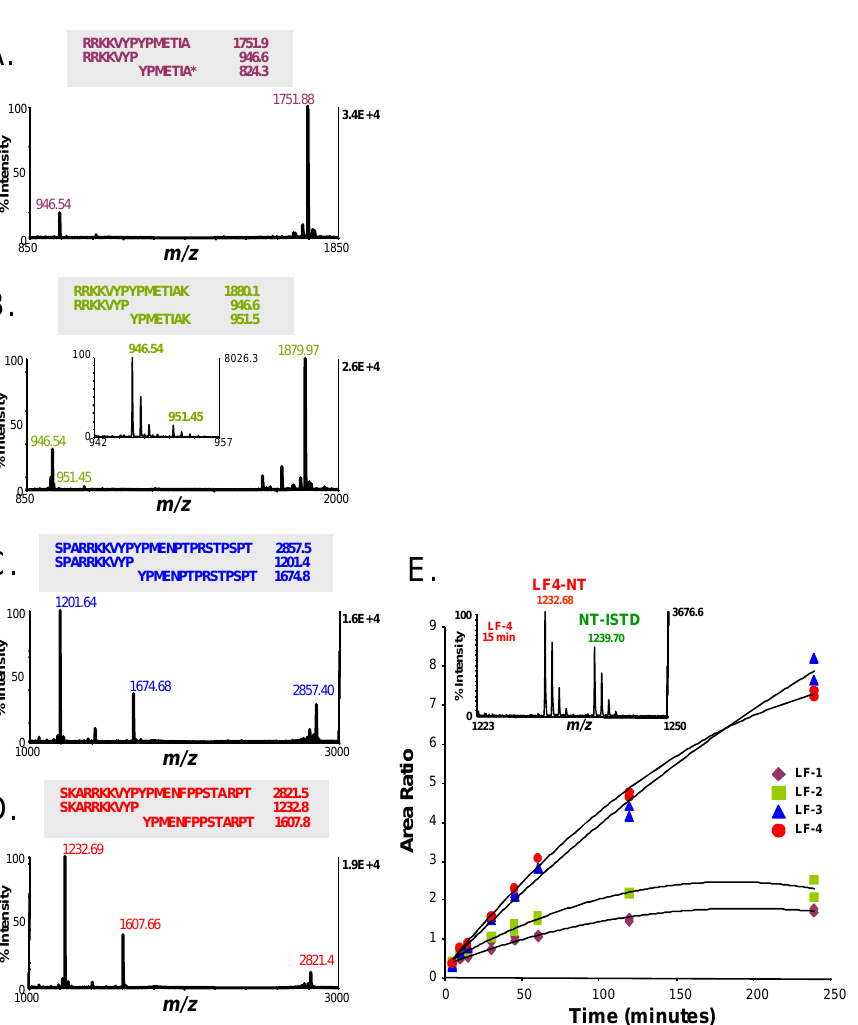
Figure 6. Comparison of cleavage efficiencies of lethal factor (LF) for various substrate peptides. Four peptides, LF-1, -2, -3, and -4, designed as potential substrates for LF, were compared to determine substrate qualities that produce enhanced LF hydrolysis. Full and expected LF cleaved peptide sequences and masses are shown for each